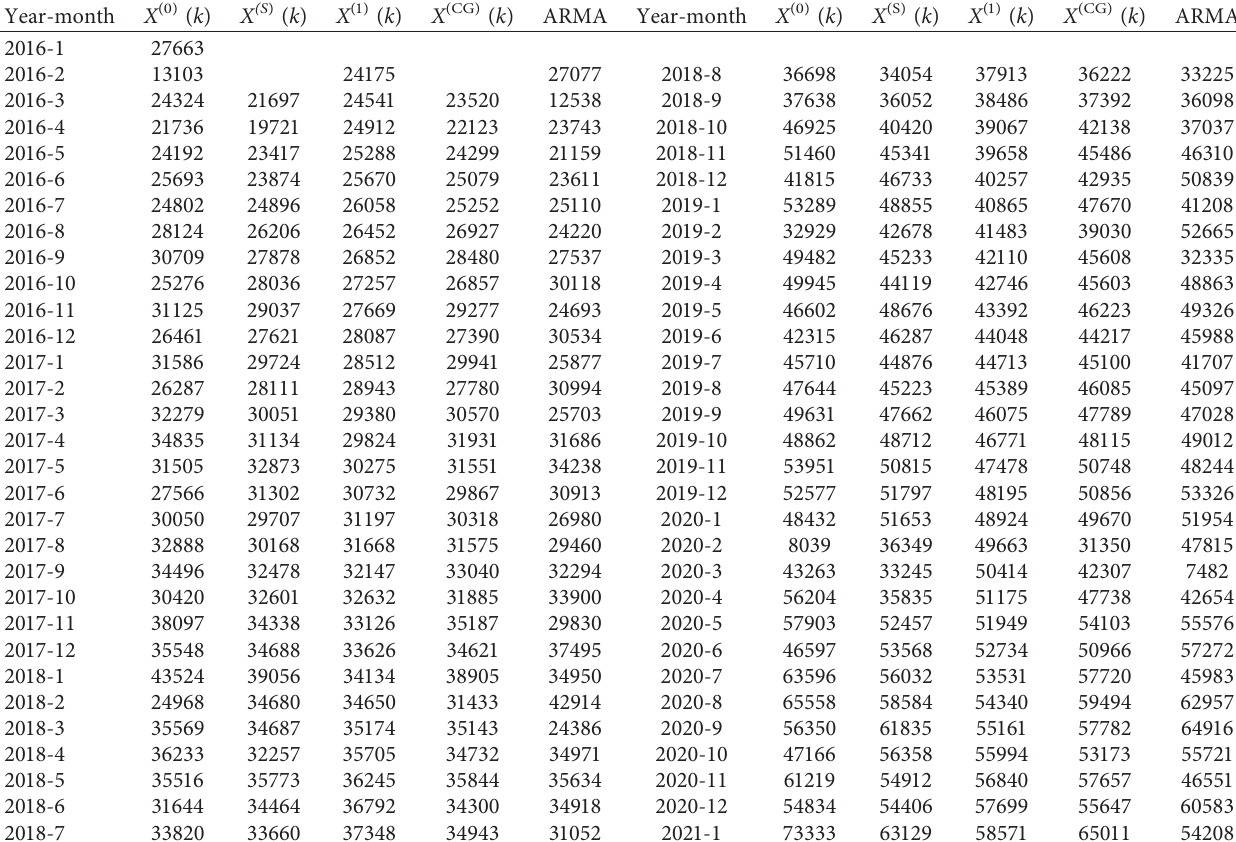
Table 1: Grey transformation data of BMW sales volume.